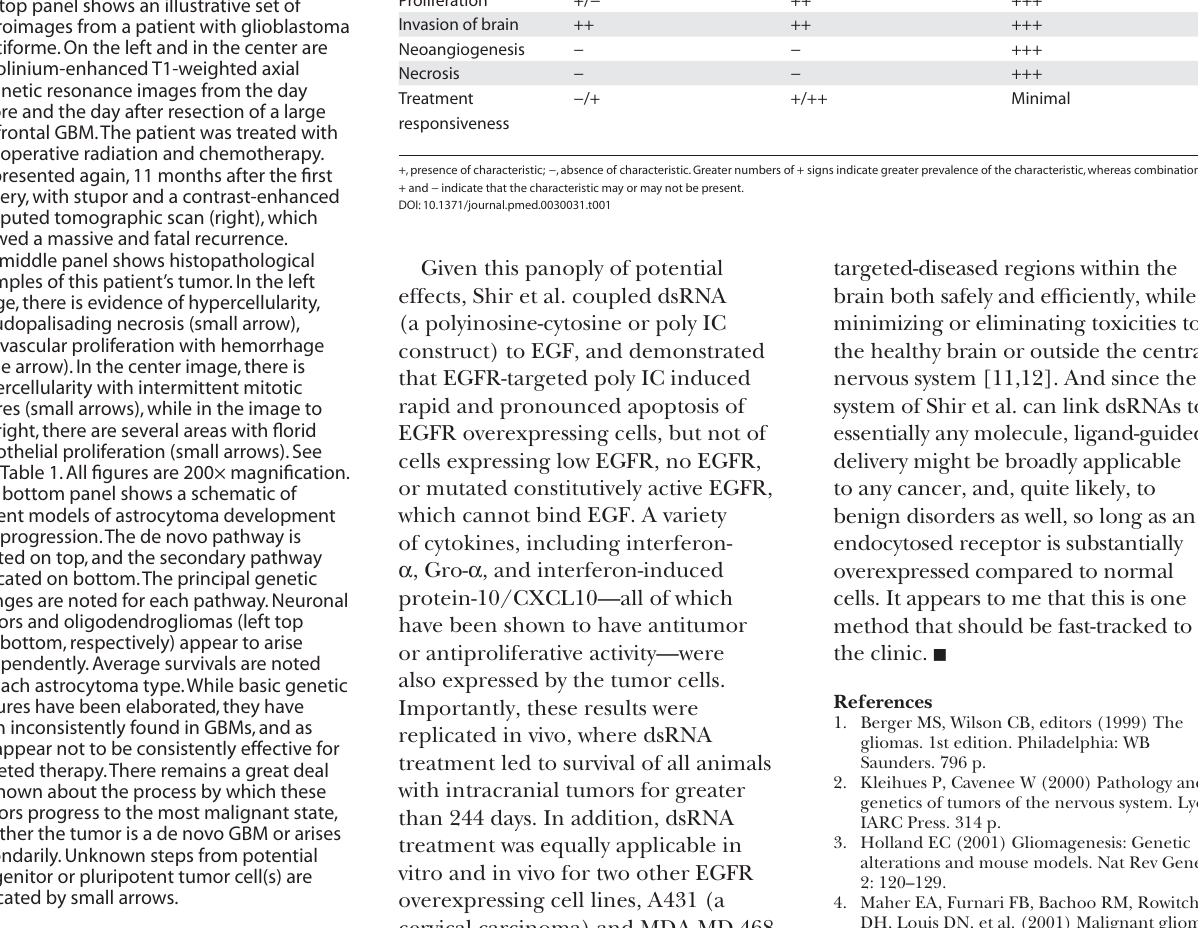
Figure 1. Representative Clinical, Pathological, and Molecular Genetic